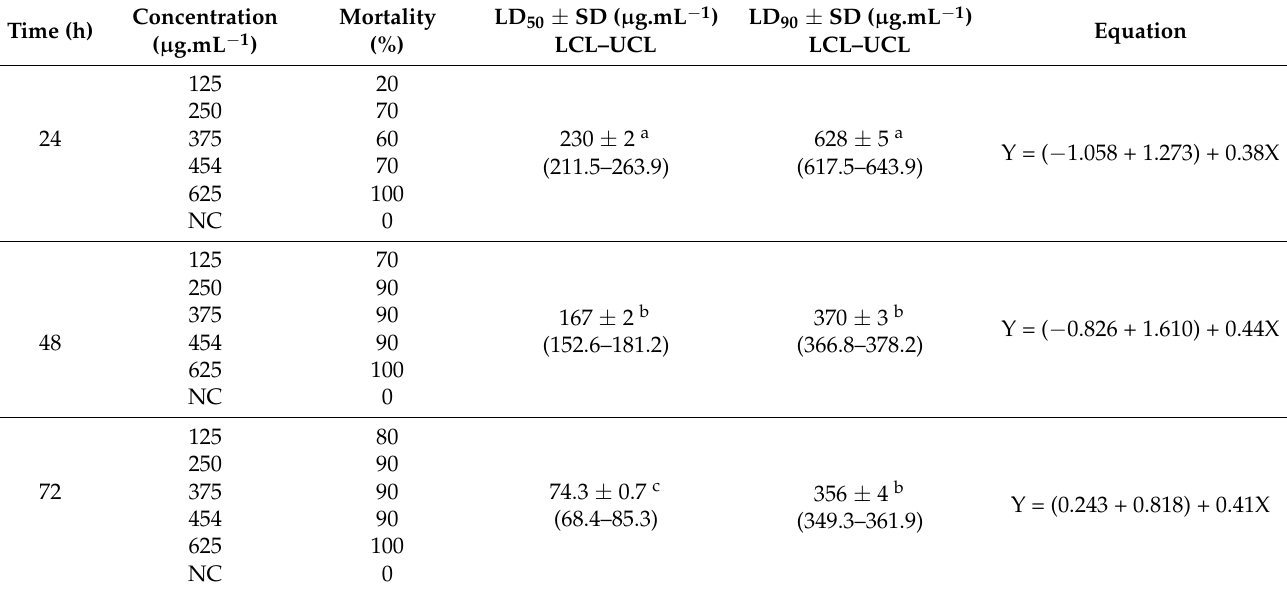
Table 3. The in loco LD 50 and LD 90 values of Piper nigrum essential oil against A. aquasalis